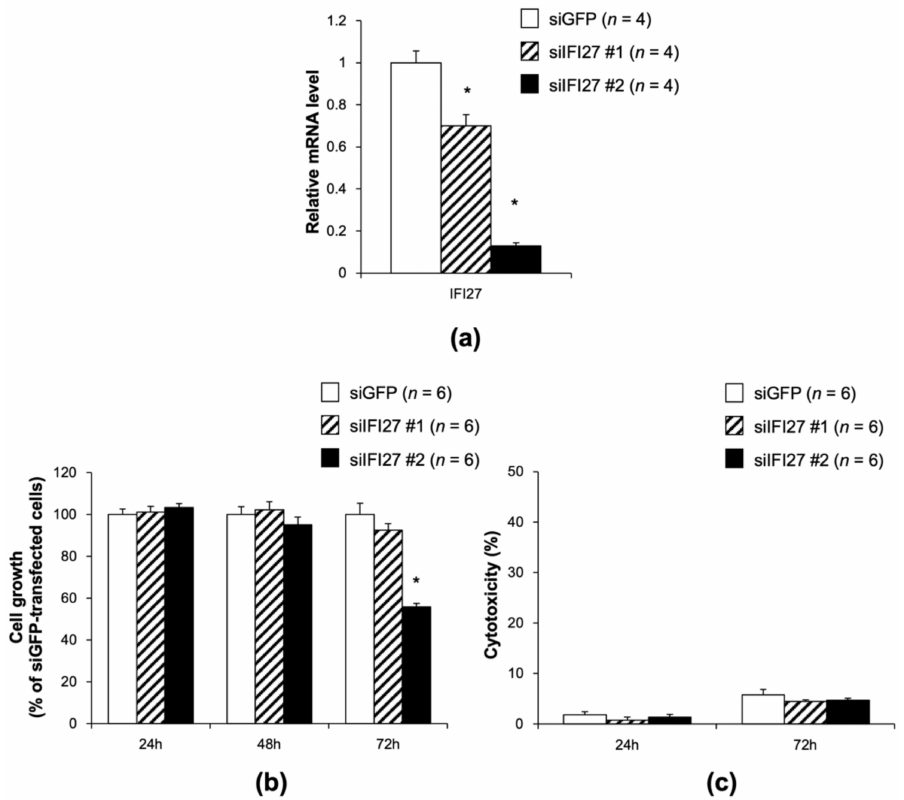
Figure 5. Effect of the knockdown of interferon α -inducible protein 27 ( IFI27 ) on the proliferation of 85As2 gastric cancer cells. ( a ) Seventy-two hours after transfection with siIFI27, IFI27 mRNA levels in 85As2 cells were measured. After 24 h, 48 h or 72 h of transfection with siIFI27, ( b ) cell growth and ( c ) cytotoxicity were measured. siGFP was transfected as a control. n = 4–6, means ± SE. * p < 0.05 vs.